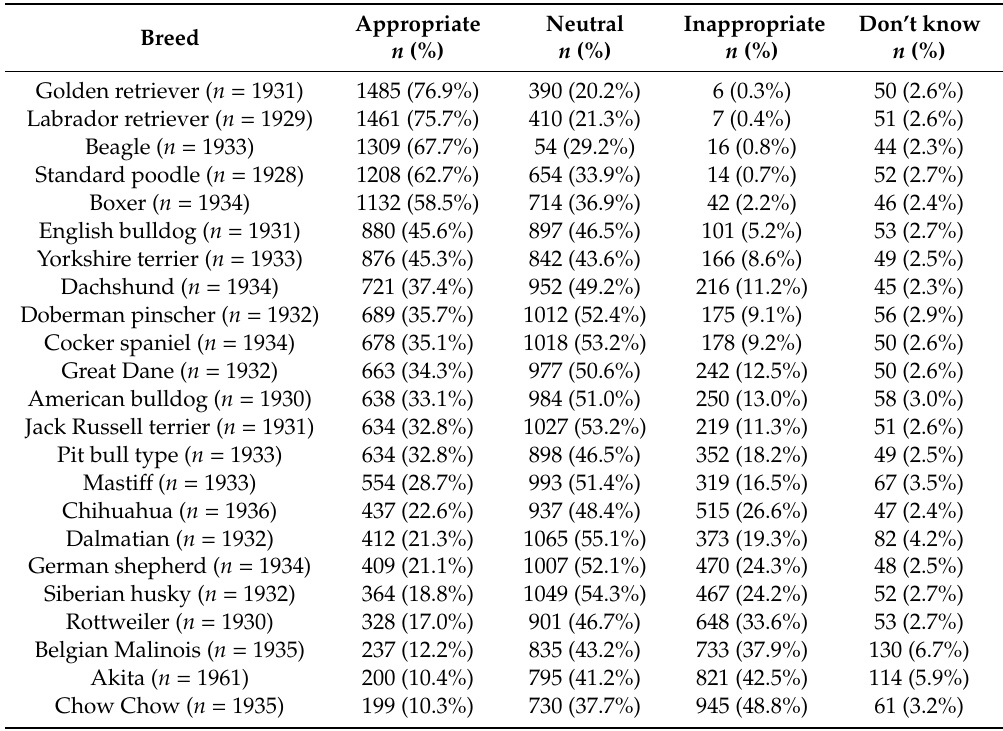
Table 7. Veterinarians’ views on the appropriateness of ownership for families with children under the age of 18 of 23 common U.S. dog